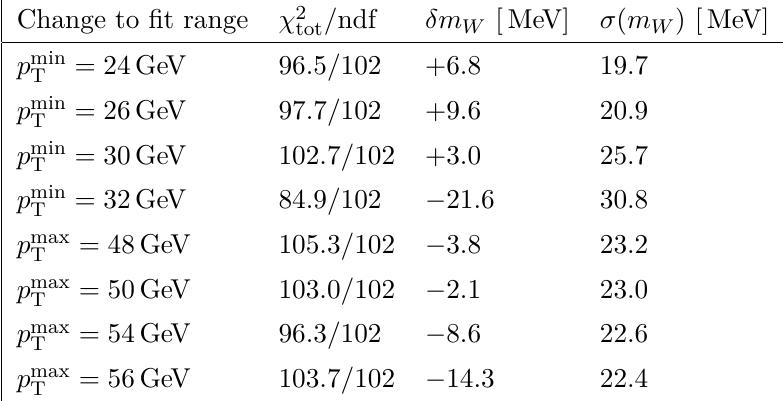
= 28 GeV and p min = T T with respect W . W